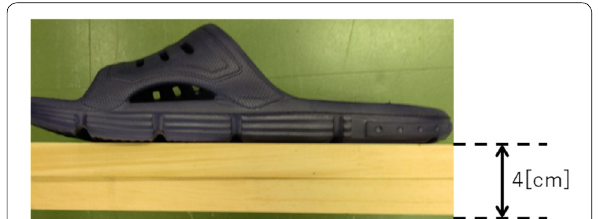
Fig. 11 The footwear with an attached block of 4 cm height on the sole of the right foot—this allowed us to make measurements of asymmetric walking